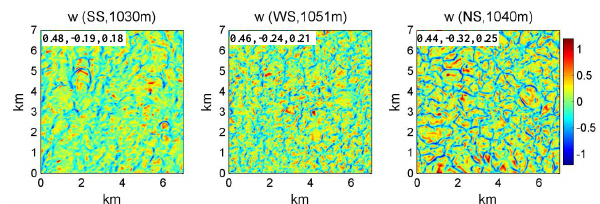
Fig. 4: Plan view of w´ at the maximum buoyancy level at 0900 LT for each simulation. Left panel is for SS, center WS, and right NS. To estimate the quantitative changes in the charac- teristics of updrafts ( w´ > 0) and downdrafts ( w´ < 0), the fractional area and averaged vertical velocities are calculated and shown on the upper-left corner. The first number is for downdraft fraction area, the second the averaged downdraft velocity, and the third the averaged updraft.